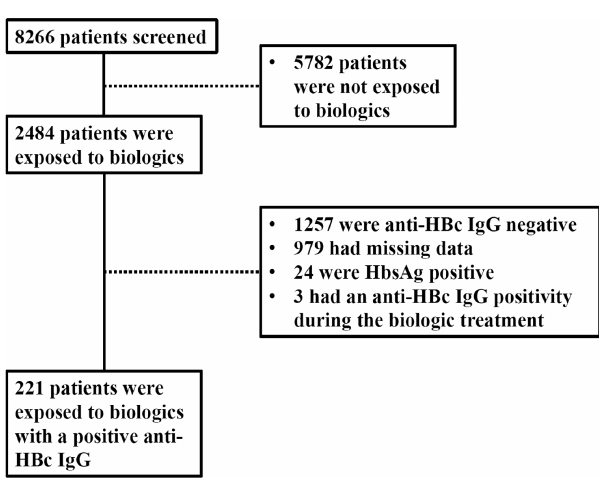
Figure 1. Patients included in the study. Study flow diagram. Anti-HBc IgG, hepatitis B core immunoglobulin G antibody; HBsAg, hepatitis B surface